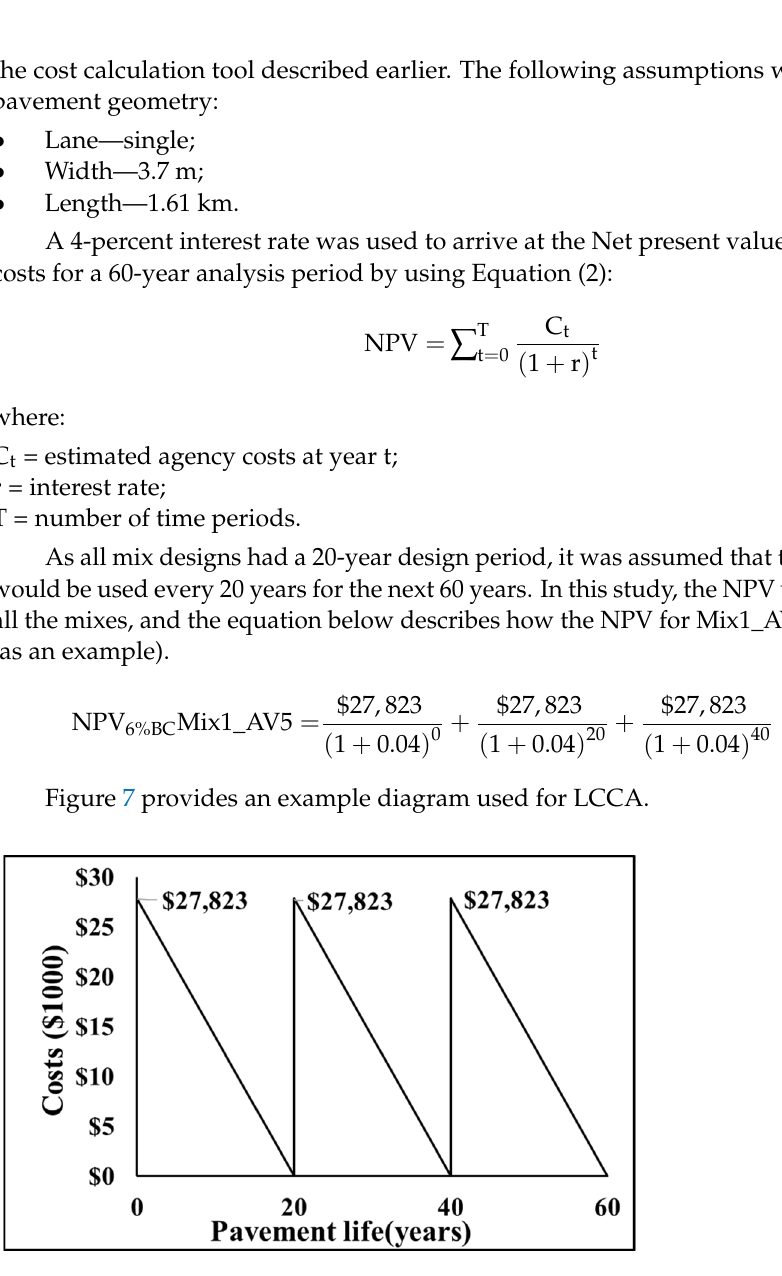
Figure 7. Diagram used for LCCA of Mix1_AV5.